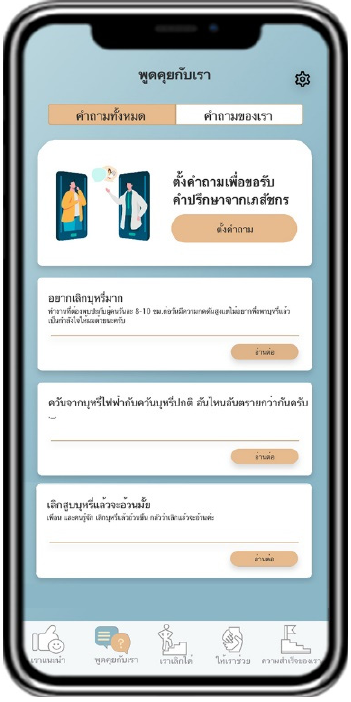
Figure 3. Display screen of Talk with US.